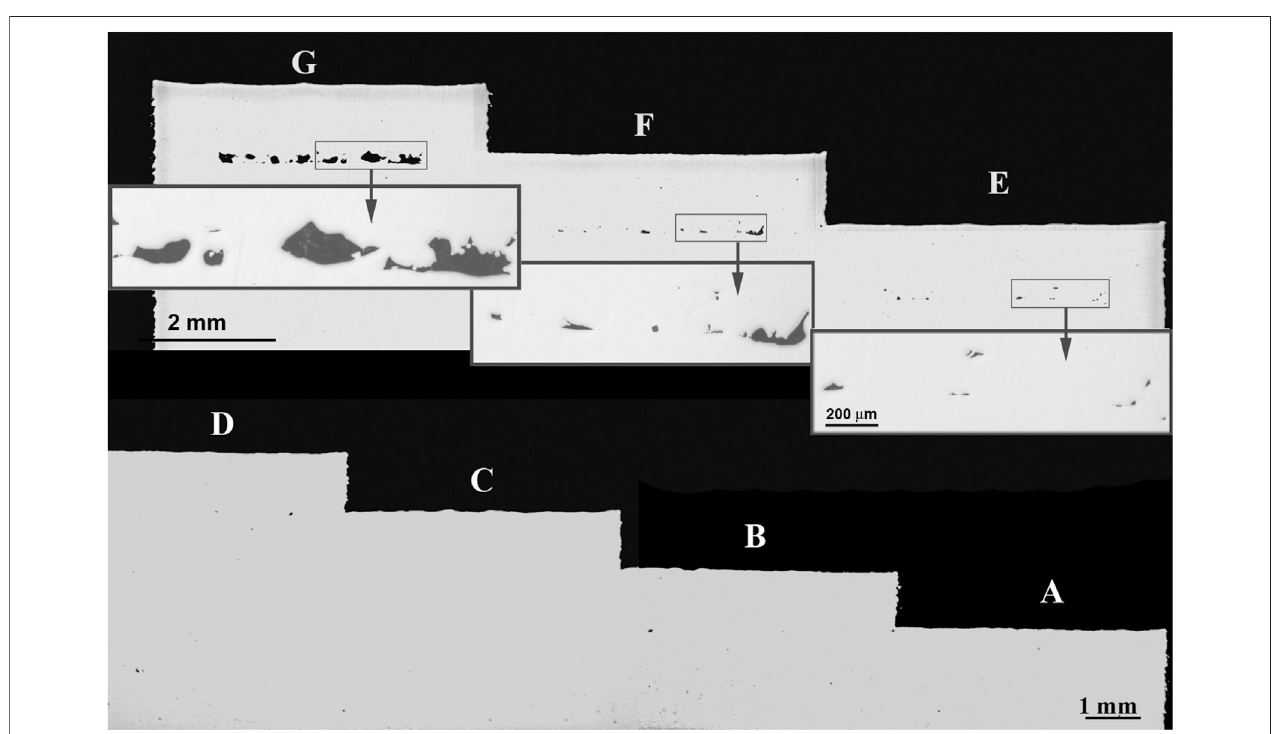
FIGURE 3 | Images from optical microscope of cross-sections of the 3D test sample with designed internal cavities of 30 – 180 µm (see also Figure 1 ).